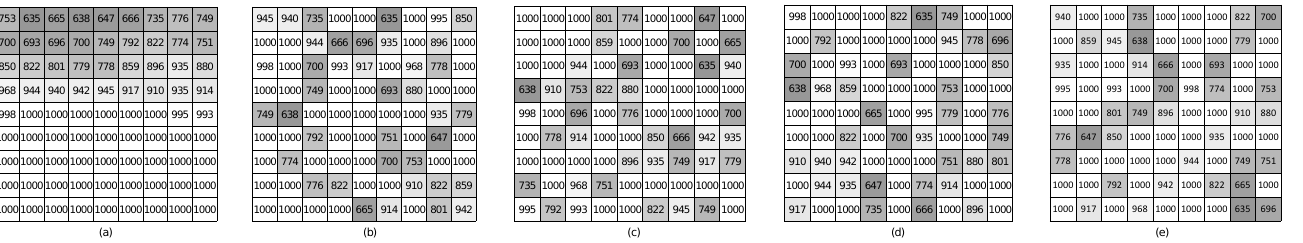
Figure 14. Shading distribution on PV array under the top edge of the cloud. ( a ) Before reconfigura- tion. ( b ) After the original PSO-based reconfiguration. ( c ) After original-Rao-based reconfiguration. ( d ) After the proposed PSO-based reconfiguration. ( e ) After proposed-Rao-based reconfiguration. (a)